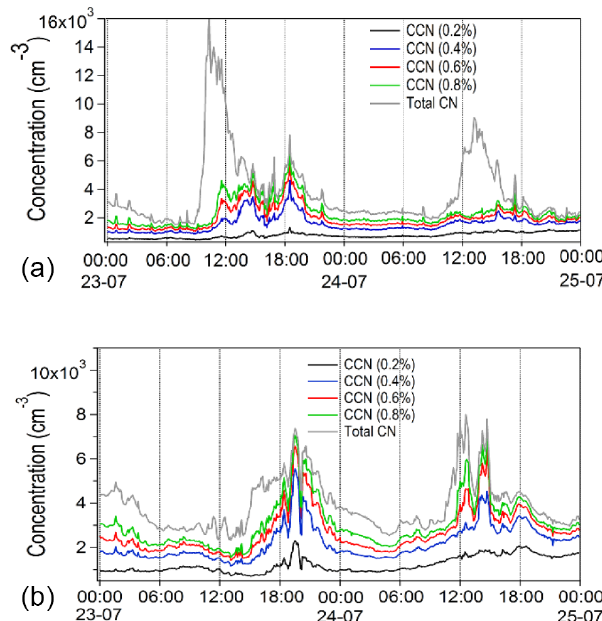
Figure 10. Time series of the estimated cloud droplet number con- centrations ( N d , red lines) and maximum supersaturation in the cloud ( s max , blue lines) for updraft velocities ( σ w ) of 0.3ms − 1 and 0.6ms − 1 at Santorini (top panel) and Finokalia (bottom panel) on 23 and 24 July (EF). Thick lines correspond to updraft velocity ( σ w ) equal to 0.3ms − 1 , while thin lines correspond to 0.6ms − 1